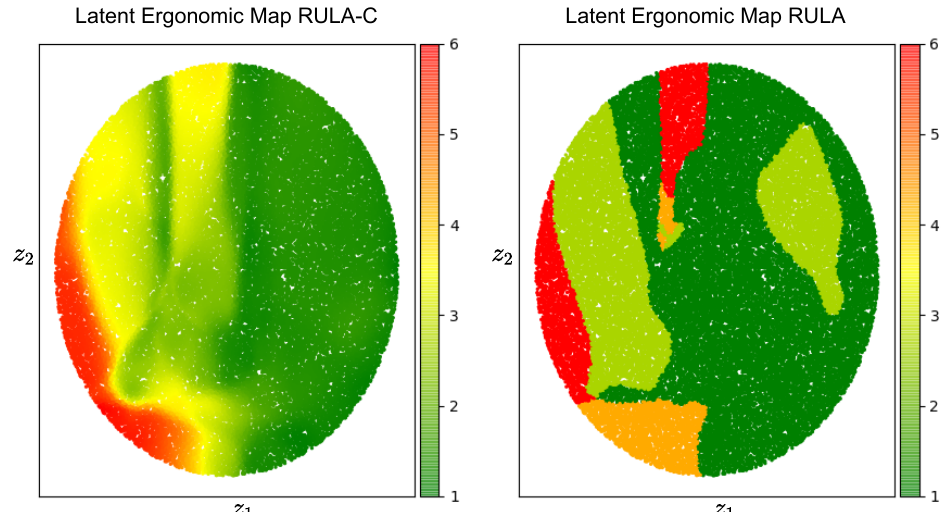
Figure 10. Latent Ergonomics Maps (LEMs): one for RULA, one for RULA-C. The figure visualizes the ergonomic data generated by the decoder network of a variational autoencoder. Here, we’ve sampled a grid of values around the origin with a radius of size 1 from a two-dimensional Gaussian and displayed the output of our decoder network. The distinct ergonomic scores which exist in different regions of the latent space smoothly transform from one to